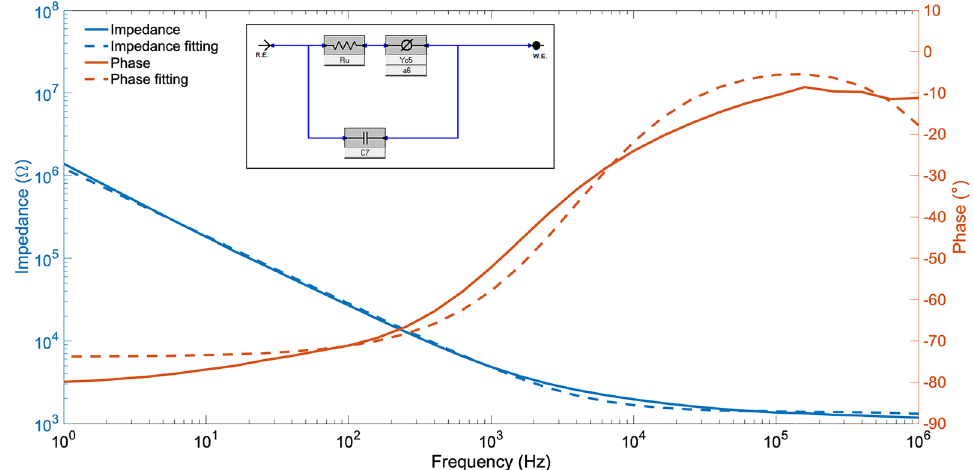
Figure 3. Representative plot of model fitting of the EIS measurements of one electrode before electrodeposition using an equivalent circuit model. The experimental data is reported in solid blue line for impedance and solid orange line for phase. The fitted impedance and phase are reported as blue dashed line and orange dashed lines separately. The inset shows the equivalent circuit model used to fit the experimental data.